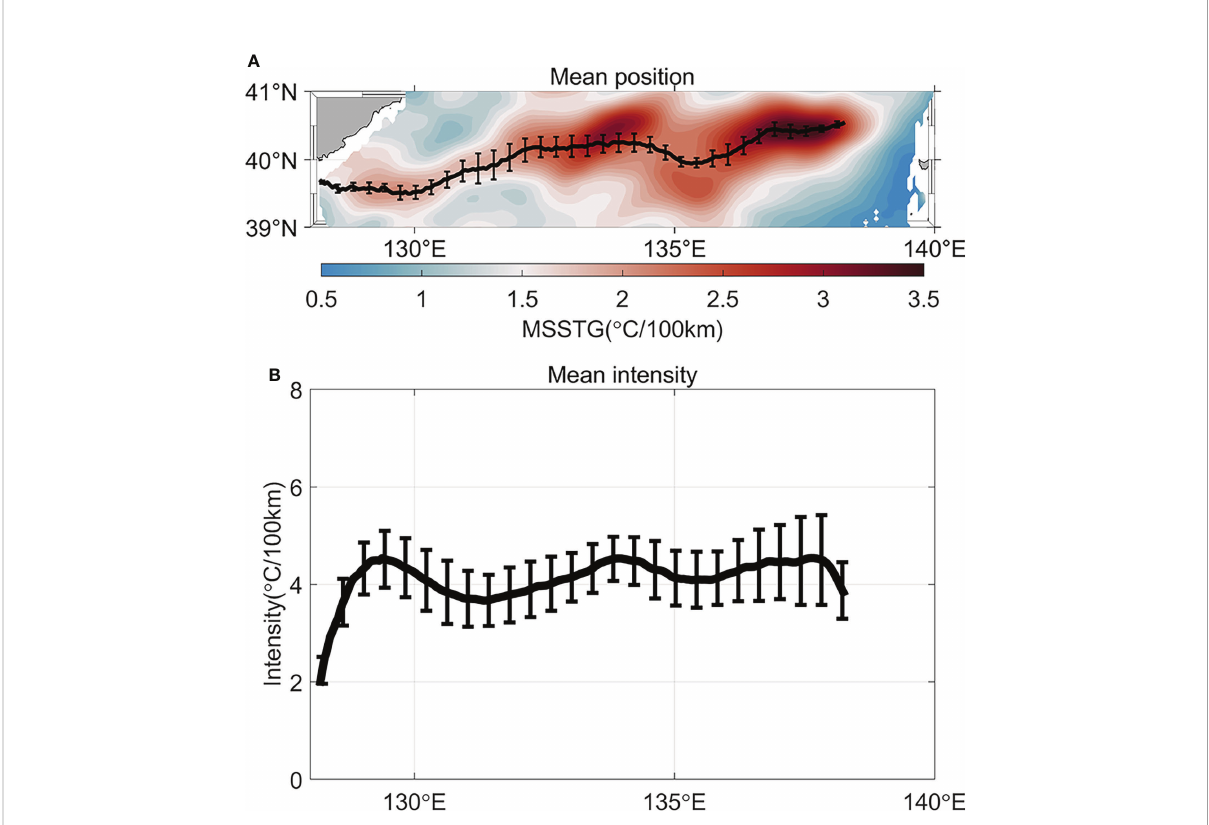
FIGURE 1 (A) The climatological position of the SPF (black lines) in the JES, and the climatological absolute value of the MSSTG (color shaded, unit: °C/ 100km). (B) The climatological intensity (unit: °C/100km) of the SPF. Error bars are the standard deviations calculated by the MSSTG with seven- year running